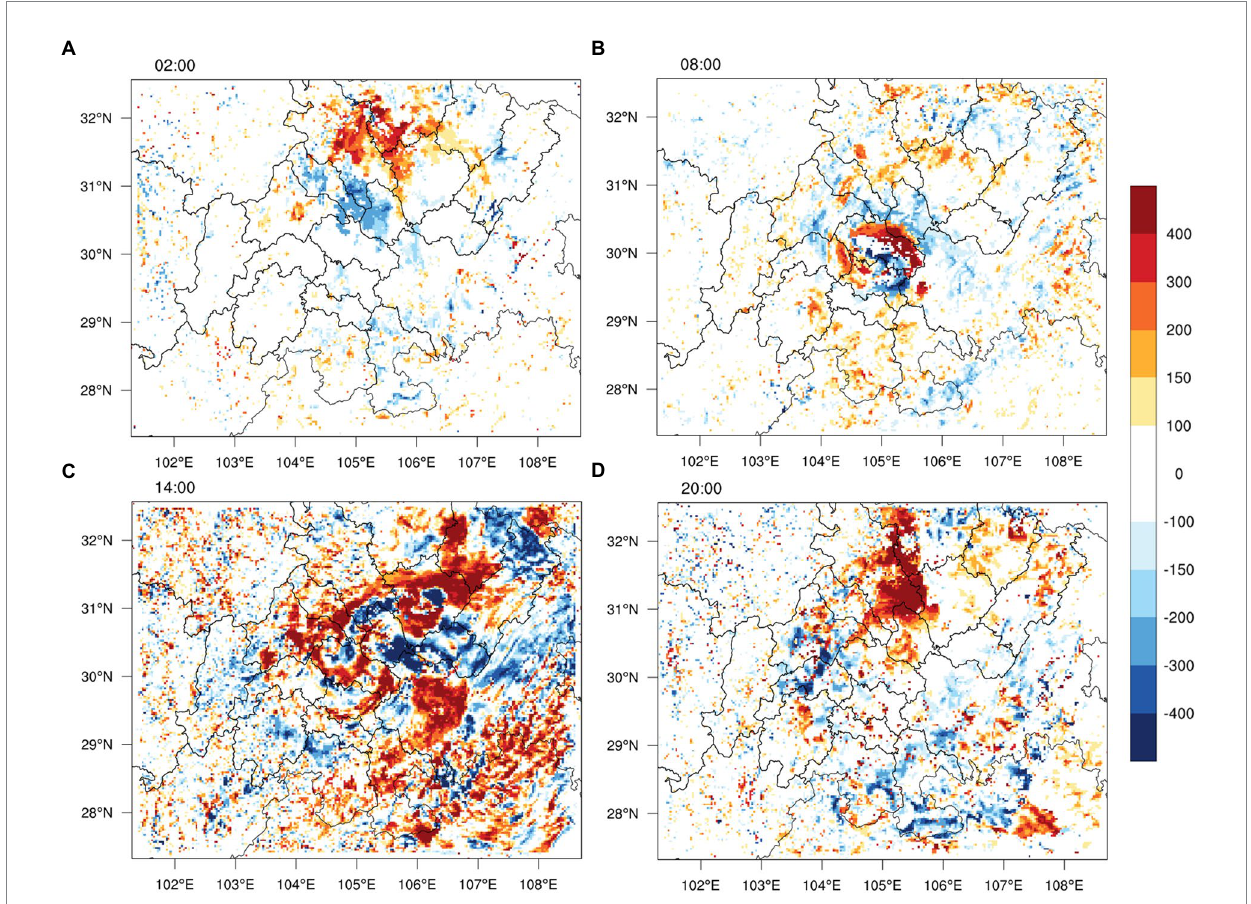
FIGURE 5 Differences in modeled monthly-averaged PBLH (m) between 2019LULC and WRF_default scenarios at 02:00, 08:00, 14:00, 20:00 over the SCB in August